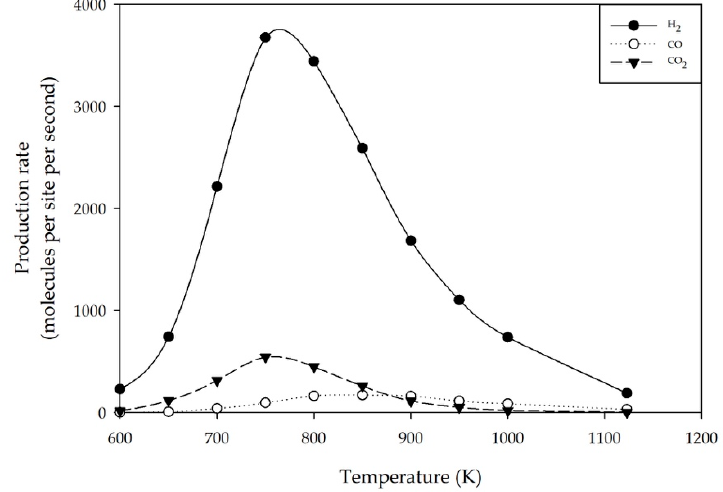
= = 0.4. Figure 7. Production rates as a function of the reaction temperature; P = 1 bar and y CH 4 (cid:3120)